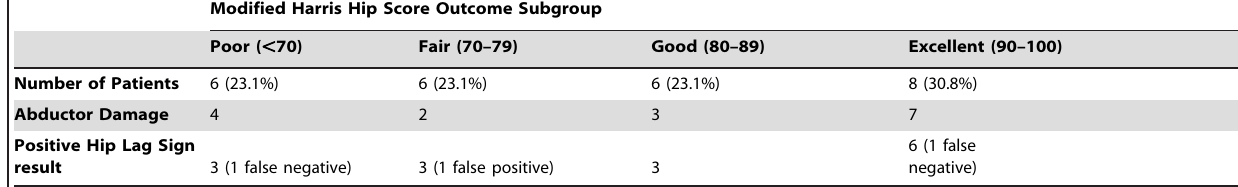
Modified Harris Hip Score Outcome